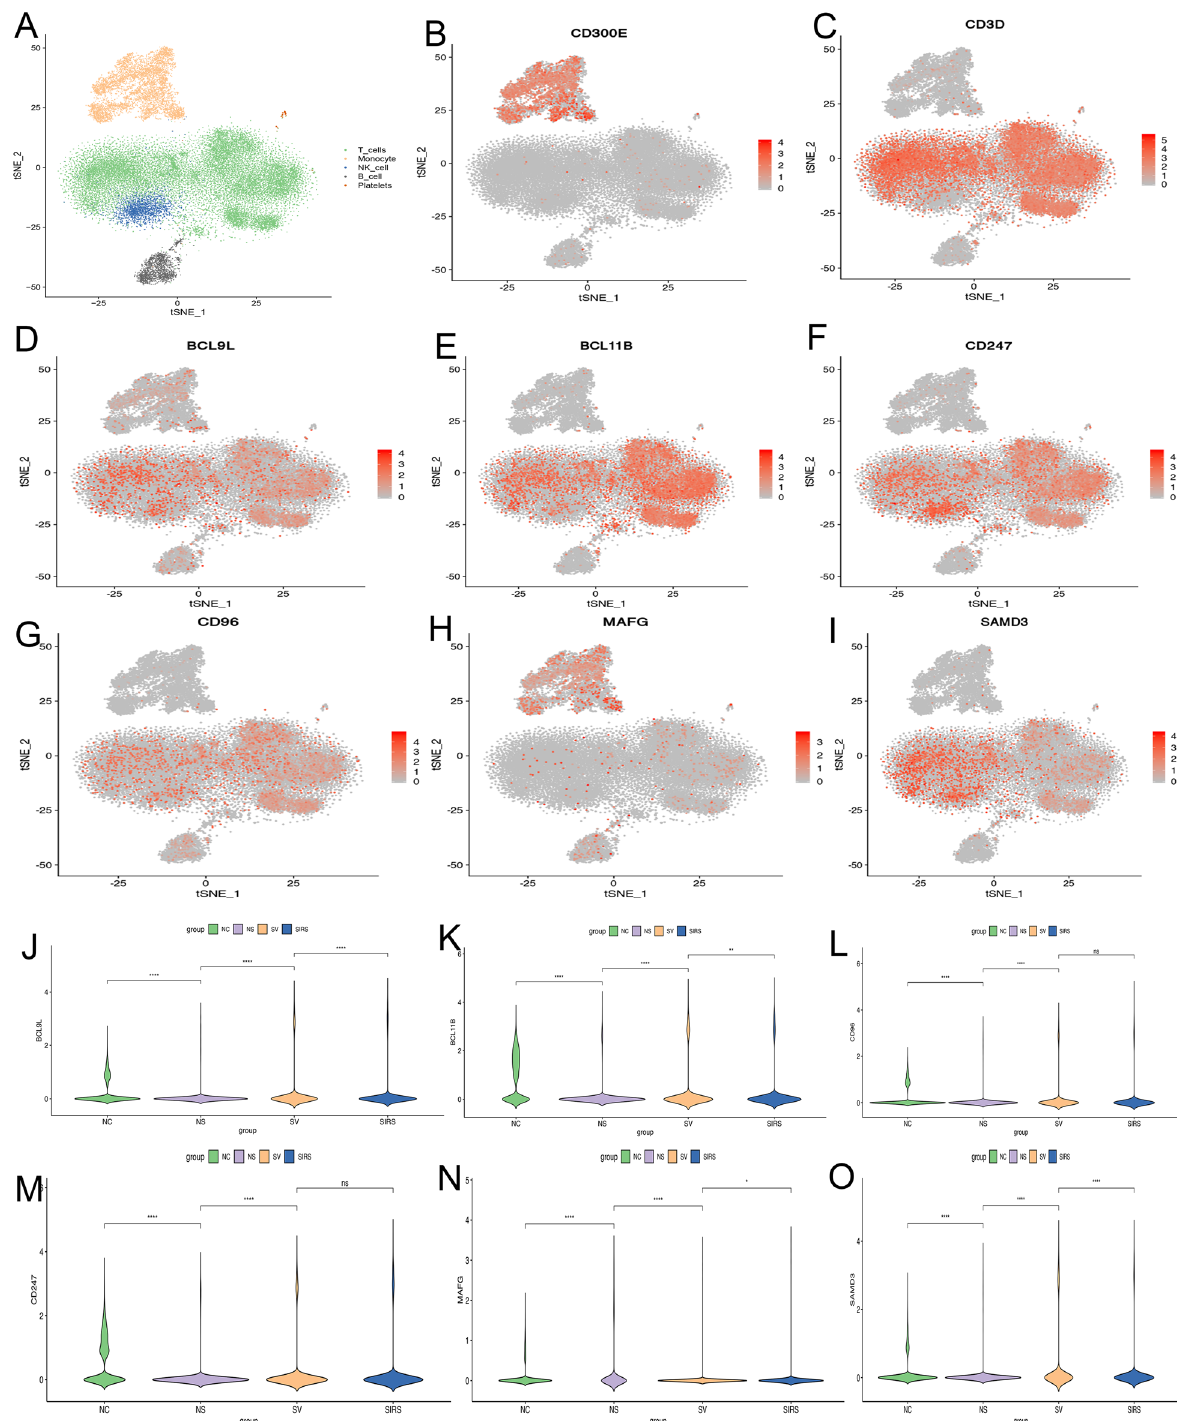
Figure 5. tSNE cell lineage location plot and multi-group comparison of pivotal genes. ( A ): tSNE overall plot of mixed samples from sepsis. Green color indicates T cell lineage; Yellow color indicates mononuclear- macrophage cell linage; Blue color indicates NK cell lineage; Grey color indicates B cell lineage. ( B ): CD300E as a biomarker for myeloid cells (positive control). ( C ): CD3D as a biomarker for T cells (positive control). ( D – I ) showed tSNE plots of BCL9L, BCL11B, CD247, CD96, MAFG and SAMD3, respectively. It suggesting these 5 essential genes were predominantly in the T cell lineage of PBMC from sepsis, only MAFG was located in monocyte cell lines. ( J – O ) showed violin plots of BCL9L, BCL11B, CD247, CD96, MAFG and SAMD3 expression in different samples. Vertical ordinate indicated relative expression levels. The abscissa represents different sample: NC for normal control 1; NS for non-survival sample of sepsis; SIRS for systemic inflammatory response syndrome; SV for survival sample of sepsis. ****: p < 0.0001; ***: p < 0.001; **: p < 0.01; *: p < 0.05; ns: p ≥